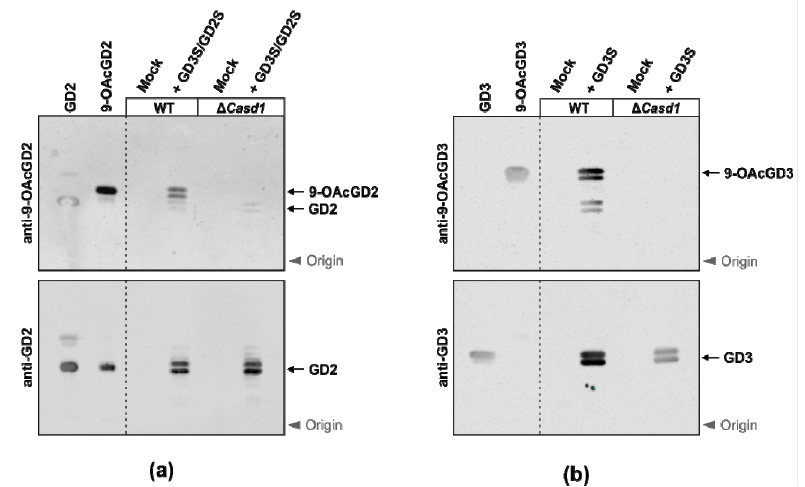
Figure 3. CASD1 induces the O -acetylation of GD2 and GD3 in CHO cells. Total gangliosides were extracted from CHO-WT or CHO ∆ Casd1 cells transfected with empty vector (mock) or a plasmid encoding the indicated synthases. The gangliosides were separated by thin-layer chromatography and stained with the indicated antibodies. Pure gangliosides and their in vitro generated 9- O - acetylated forms were used as standards (left panel). Please note that the O AcGD2 standard contains residual amounts of GD2. ( a ) CASD1-dependent formation of 9- O AcGD2. ( b ) CASD1-dependent formation of 9- O